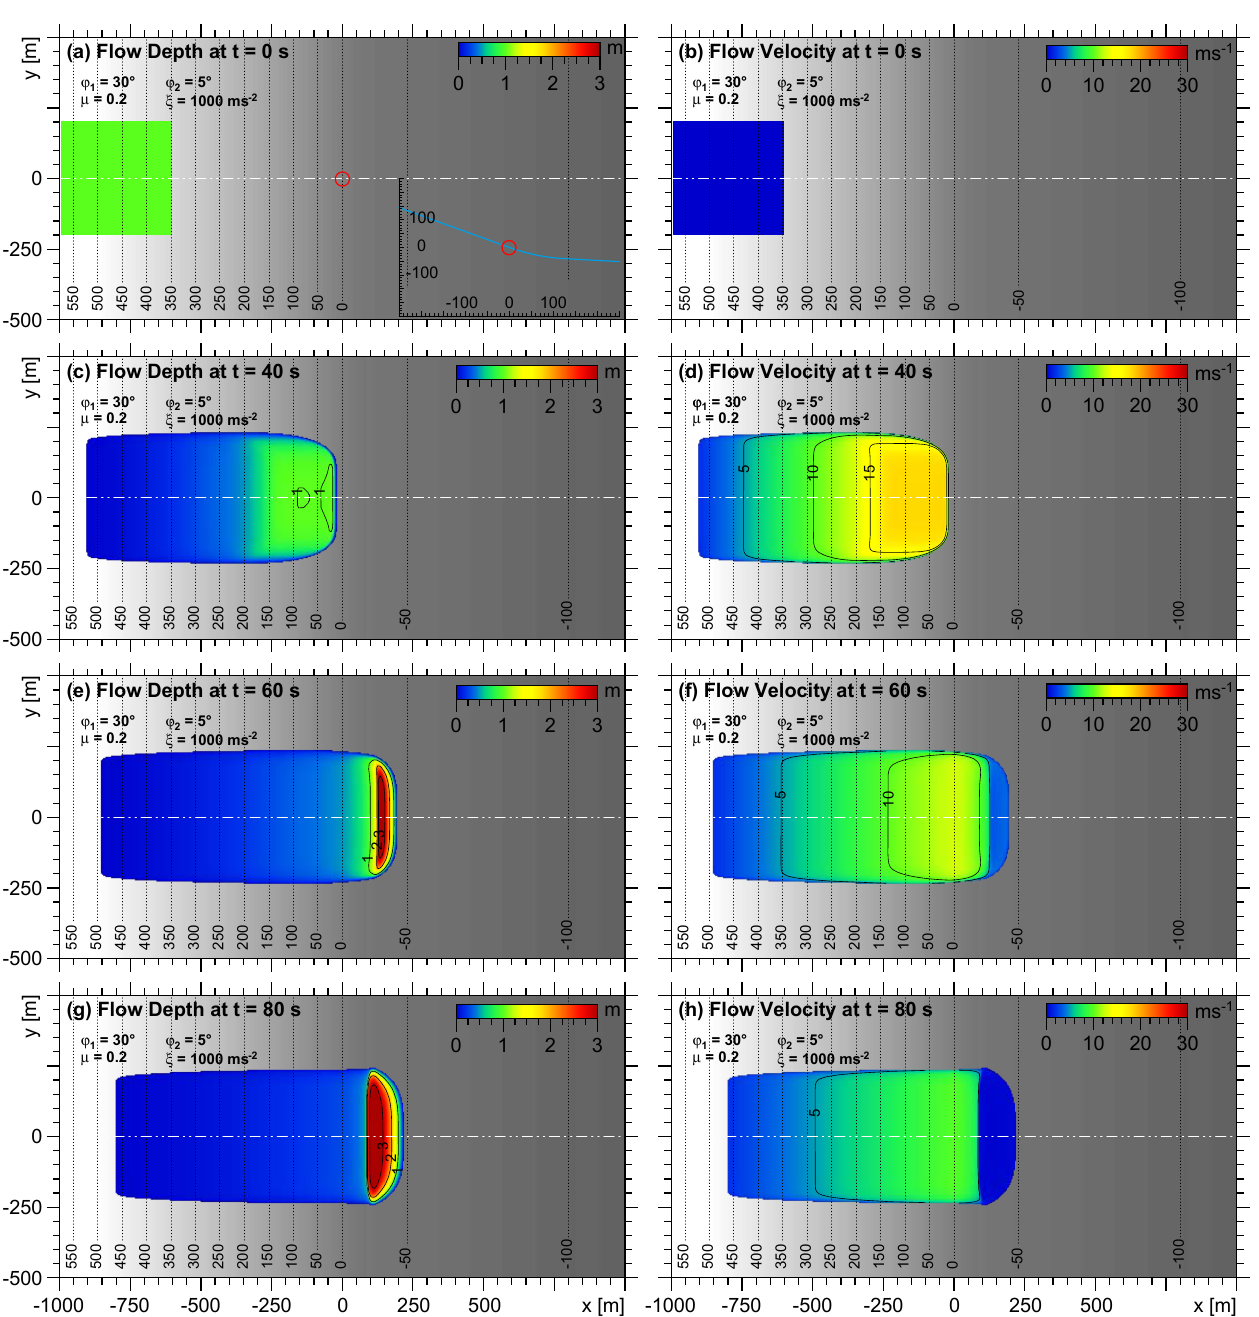
Figure 4. Two-dimensional representation of numerical solutions of GERRIS Zb for flow depth and flow velocity partly concave slope at four different time steps. The fluid layer accelerates at an inclined ramp ( ϕ 1 = 30 ◦ ) and runs out in a gently dipping surface ( ϕ 2 = 5 ◦ ) with a smooth (parabolic) transition starting at x = 0. A topographic profile of the geometry is shown in the inset of (a) . The white dashed-dotted line indicates the position of the longitudinal profiles shown in Figs. 5 and